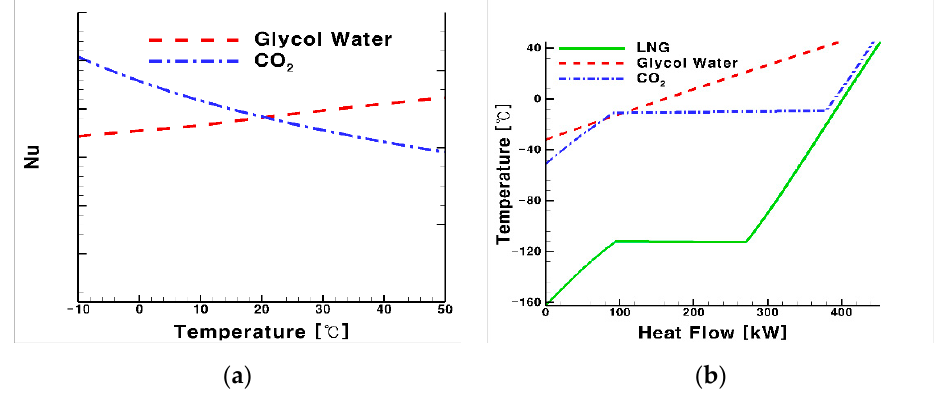
Figure 1. Heat transfer performance based on the refrigerant and heat process: ( a ) T-Q diagram classified by heat source; ( b ) Nusselt number (Nu) as a function of temperature for glycol water